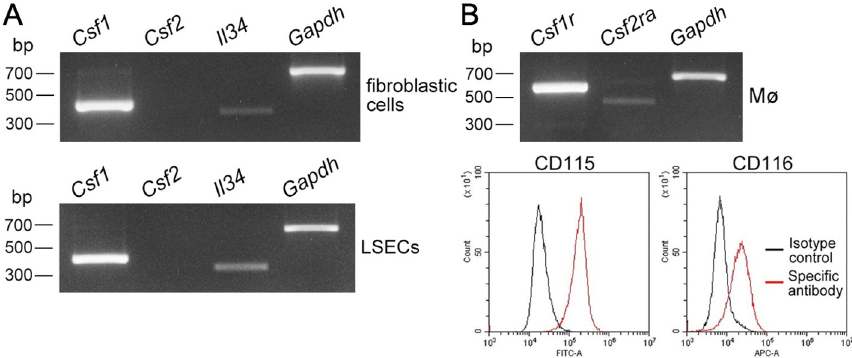
Figure 4. Expression of Mø growth factors in fibroblastic cells and LSECs as well as of their corre-